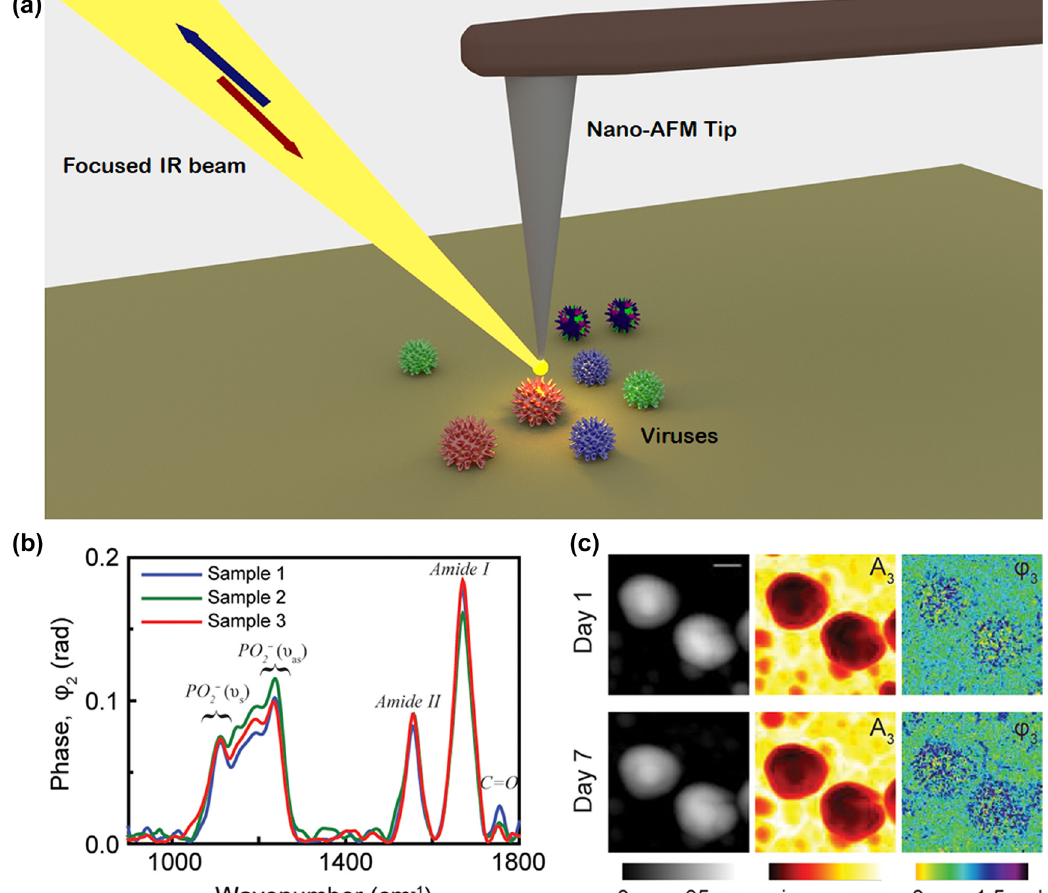
Figure 4: Illustration of the nano-Fourier transform infrared (nano-FTIR) technique for virus detection. (a) Schematic diagram of the s-SNOM experimental setup. (b) Nano-FTIR spectra of an influenza virus particles from three different samples at neutral pH demonstrating the reproducibility of nanoscale analysis. Adapted with permission from ref. [55]. Copyright [2018] PLOS. (c) Topography, near-field amplitude (A3) and phase ( 𝜑 3) images representing reflectivity and absorption of two influenza virus particles on day 1 and day 7. Scale bar 100 nm. Adapted with permission from ref. [55]. Copyright [2018]